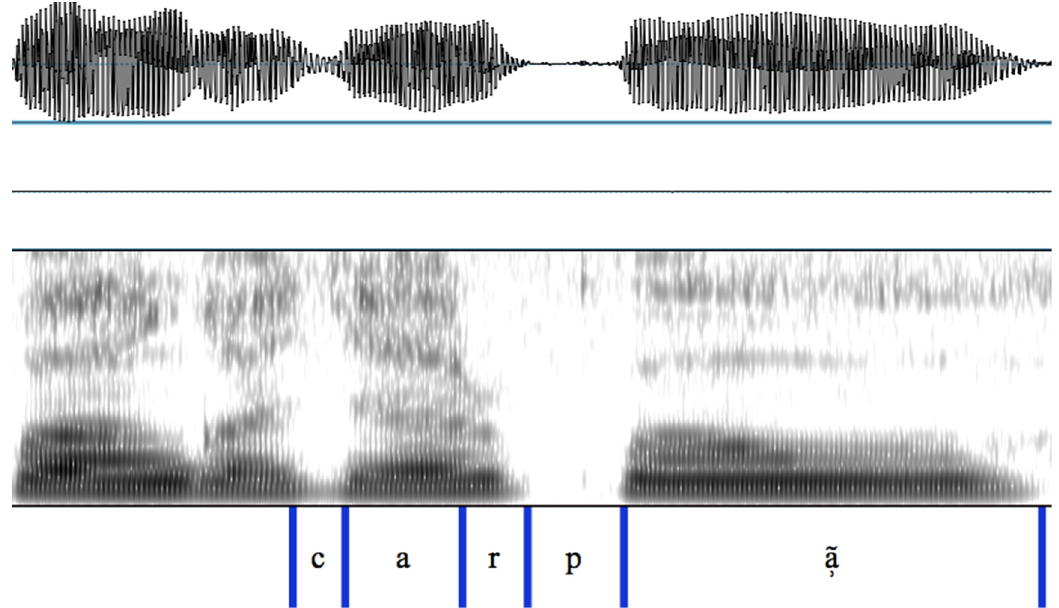
Figure 5. Example of nasalization and rounding on the final vowel segment of the verb stem (carpa- ŋ u ‘enter- PST ’) (Umatji_frog-mamu-ECOM).